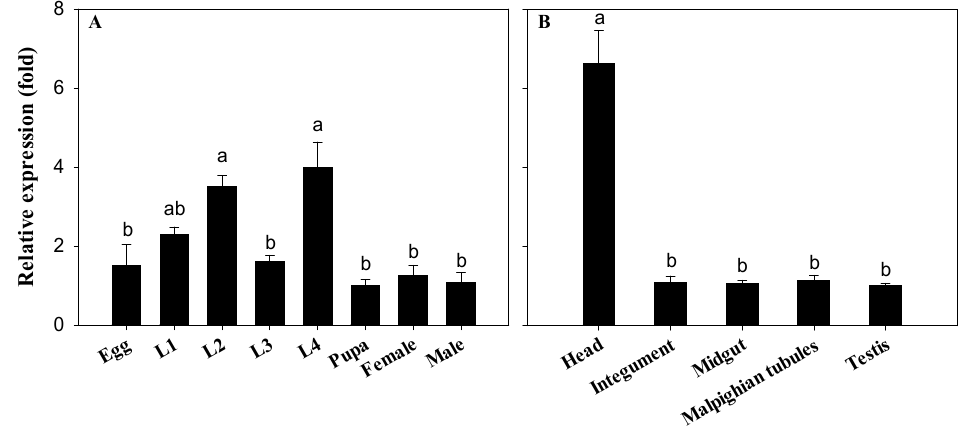
Figure 2. Expression profiles of CYP340W1 in different developmental stages ( A ) and tissues of the fourth instars ( B ) of ABM-S. L1 to L4: the first- to fourth- instar larva. Expression in pupa ( A ) and midgut ( B ) was set to 1. Values are means ± SEs for three independent replicates. In each panel, means with different letters are significantly different ( p < 0.05; Tukey’s test).